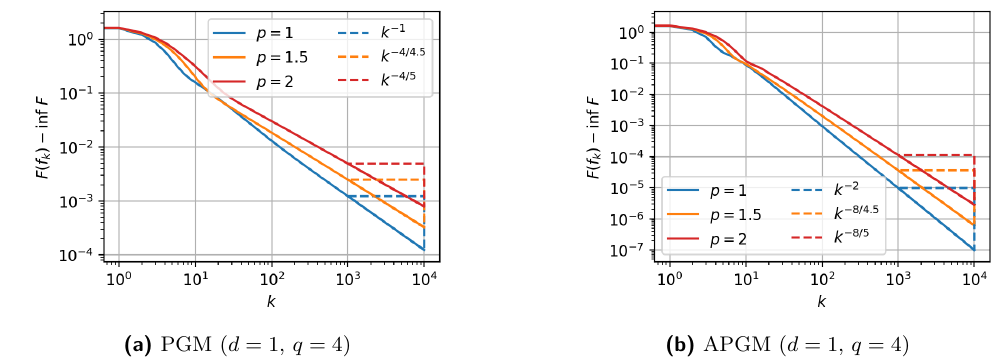
Figure 4 Convergence of PGM and APGM vs. theoretical rates (up to log factors) in a sparse deconvolution problem with H = ι M and d = 1. Here p refers to the parameter of η p and p = 1 + (Θ) refers to η ent . The objective has structure (II*) so q = 4 in the rates of Table 2.